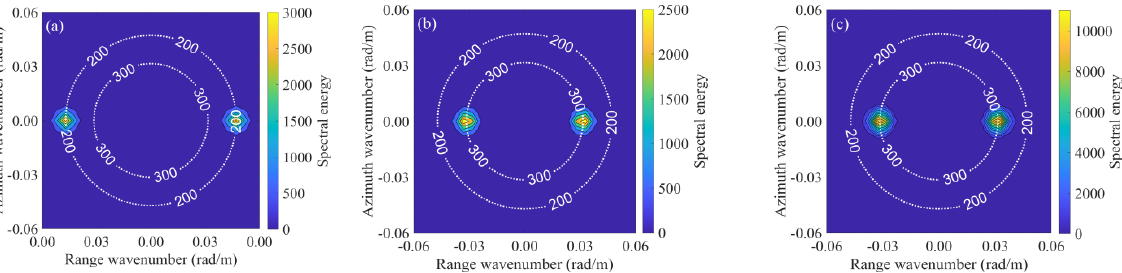
Figure 2. The swell spectrum with different significant wave heights and dominant wave wavelengths. ( a ) The significant wave height of swell = 2 m, swell wavelengths = 200 m; ( b ) the significant wave height of swell = 2 m, swell wavelengths = 300 m; ( c ) the significant wave height of swell = 4 m, swell wavelengths = 300 m.